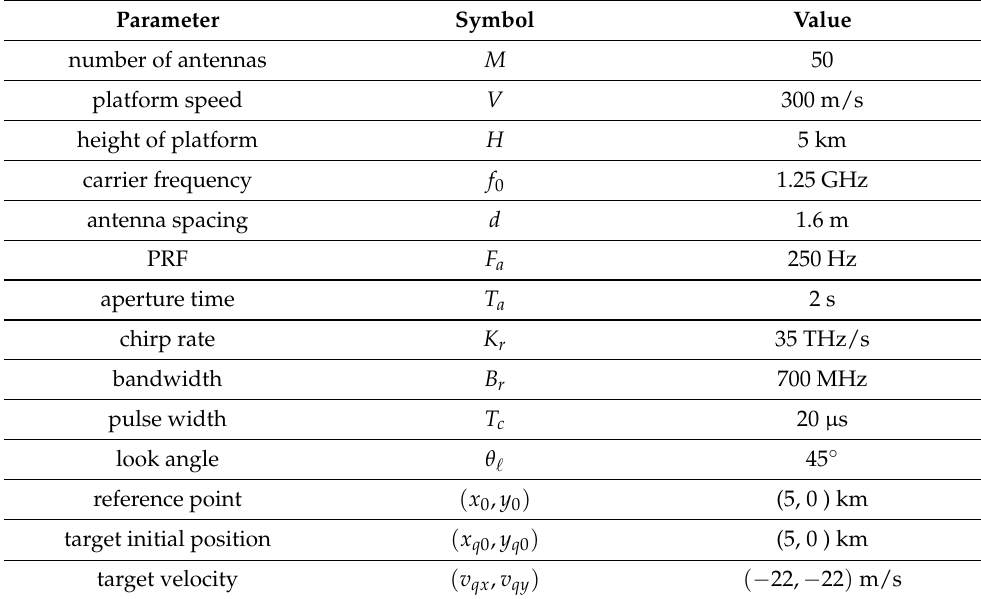
Table 6. Parameters for method